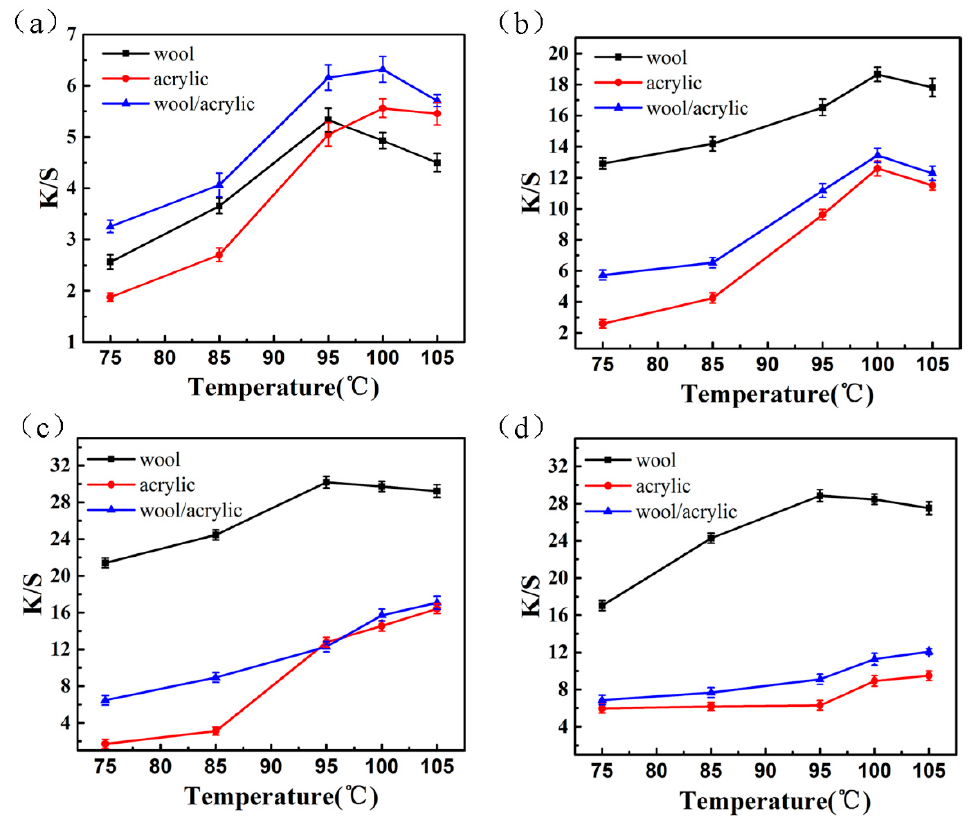
Figure 8. Effect of temperature on K/S for heterocyclic reactive dyes. ( a ) Dye 1; ( b ) Dye 2; ( c ) Dye 3; ( d ) Dye 4.